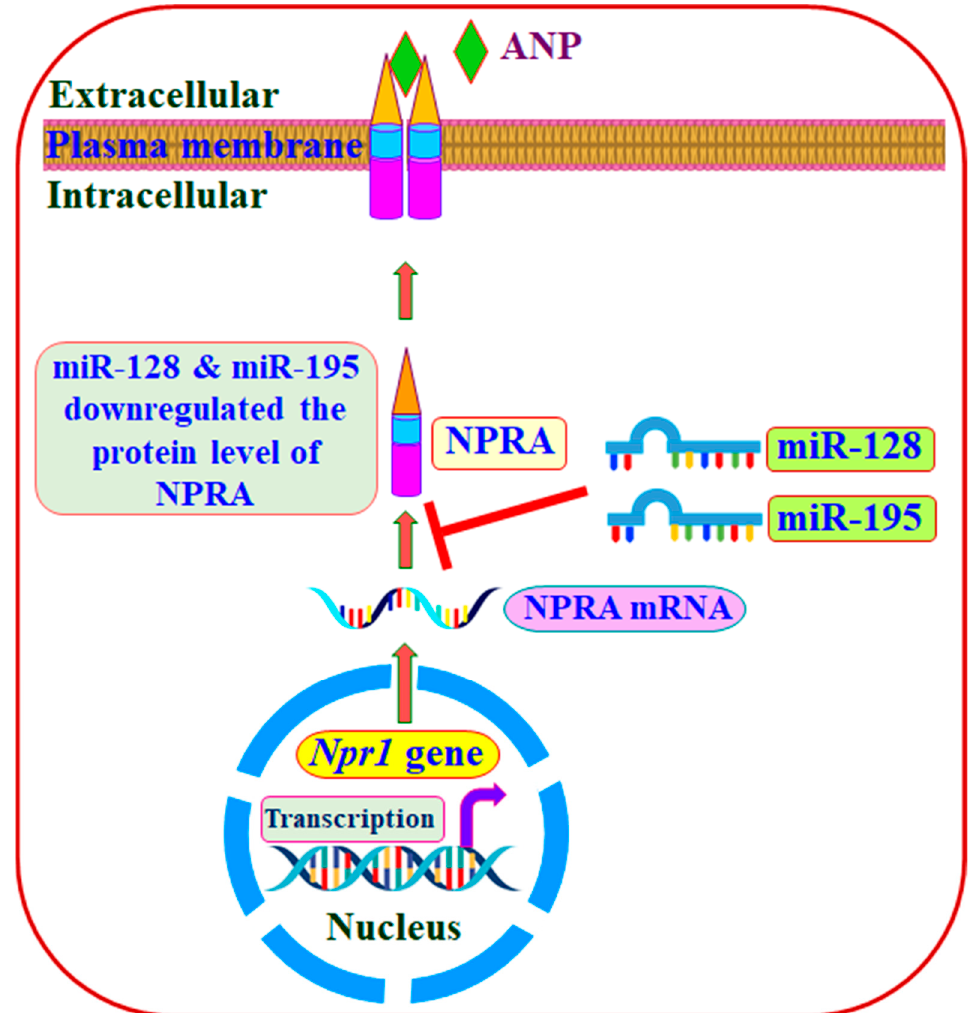
Figure 8. Schematic representation of the role of miR-128 and miR-195 in the downregulation of NPRA. miR-128 significantly downregulated NPRA compared to miR-195. ANP-dependent downregulation of NPRA (ANP-NPRA complex) as compared to control cells, and downregulation of NPRA through miR affects ANP/NPRA/cGMP signaling.